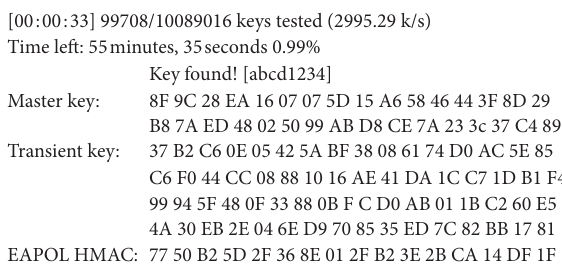
Figure 11: Aircrack-ng crack WPA results.